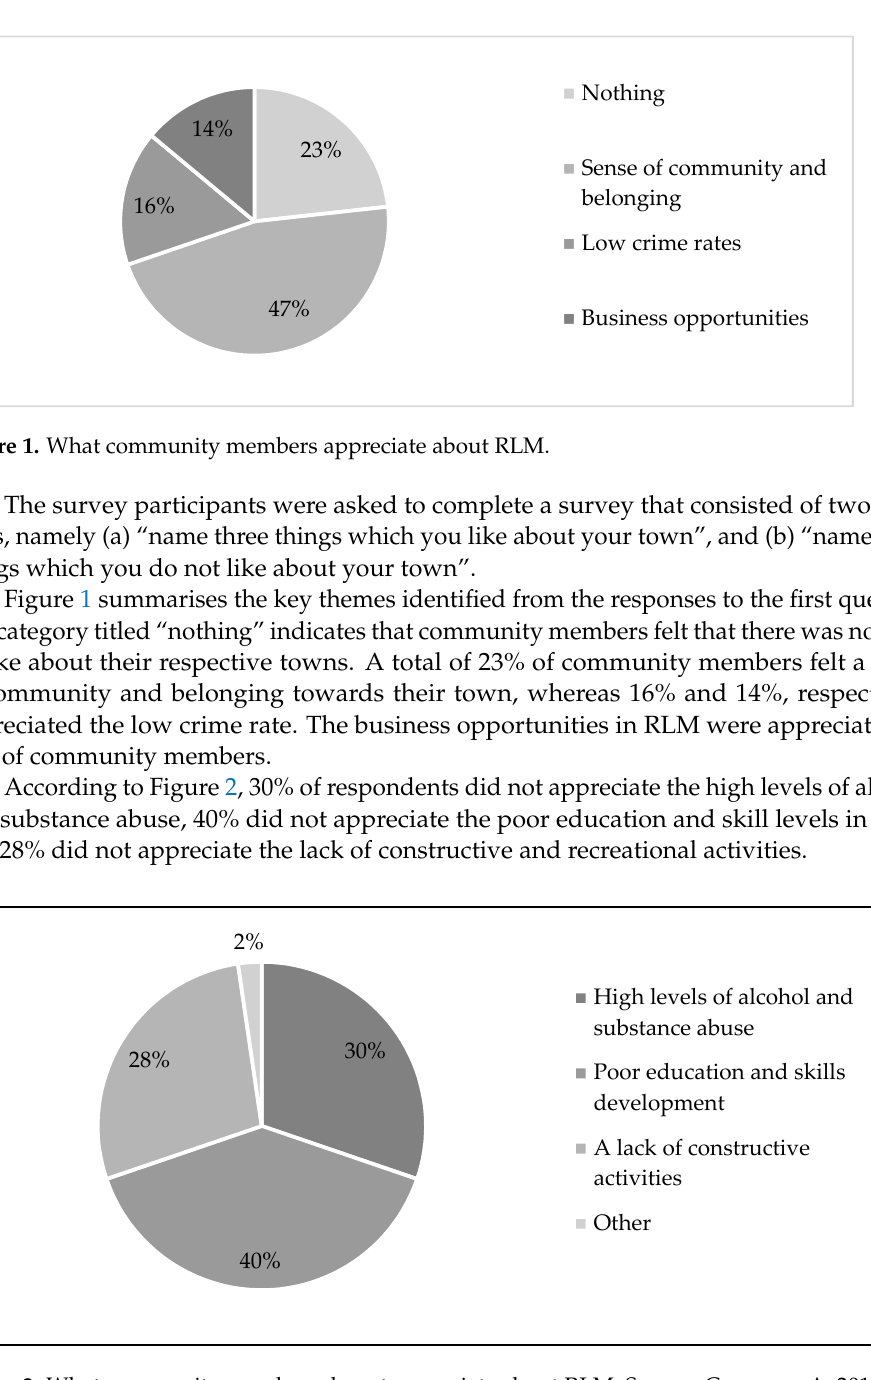
Figure 2. What community members do not appreciate about RLM. Source: Company A, 2017.